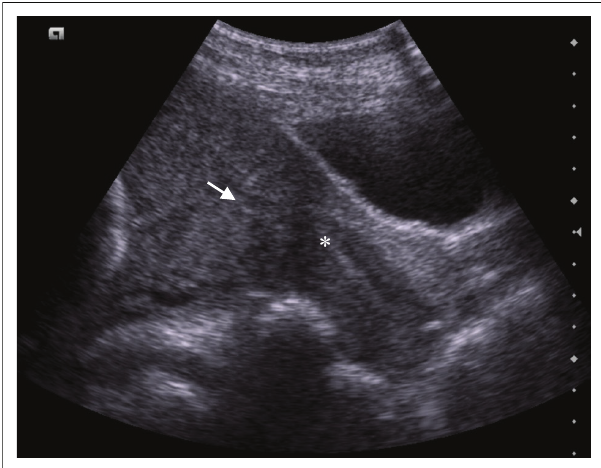
FIGURE 2: Longitudinal abdominal ultrasound demonstrating placental tissue (white arrow) overlying the internal ostium (os) of the cervix (asterisk).